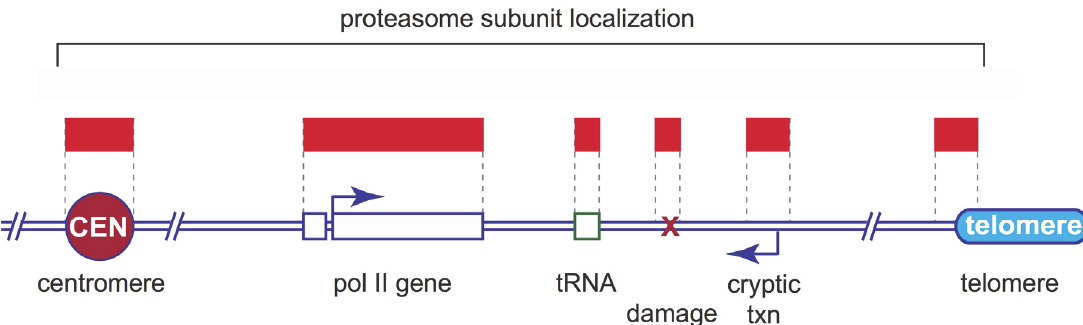
Figure 1. Localization of proteasomes on chromosomes. The cartoon shows an idealized eukaryotic chromosome, depicting the centromere (“CEN”) a pol II-transcribed gene, a tRNA gene, a site of DNA damage, a site of cryptic transcription (“cryptic txn”) and a telomere. Above the cartoon, symbolized with red bars, are regions shown to be bound by one or more proteasome